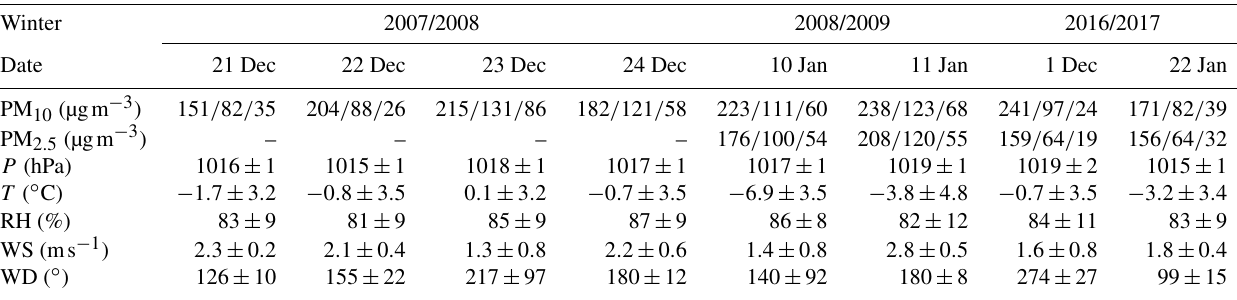
Figure 2. Diagram representing the number of days comprising at least one station where a threshold is exceeded (light colours for infor- mation and dark colours for alert) for each winter of the past decade. The stations taken into account are only background ones. The station typing (urban, light–deep blue; suburban, yellow–orange; and rural, light–deep green) is conserved to appreciate the spatial extent of a typical polluted day. Table 2. The 8 most severely polluted winter days of the past decade. For each day we give both PM 2 . 5 and PM 10 measured at ground level (Airparif network) in the format max/mean/min, where max and min are the hourly maximum and minimum value measured at a given background station during the day and Mean is the daily average over all background stations. Meteorological parameters (ECMWF ERA5) at ground level are also given: pressure ( P ), temperature ( T ), relative humidity (RH), wind speed (WS), and wind direction (WD) with the standard deviation associated with the daily